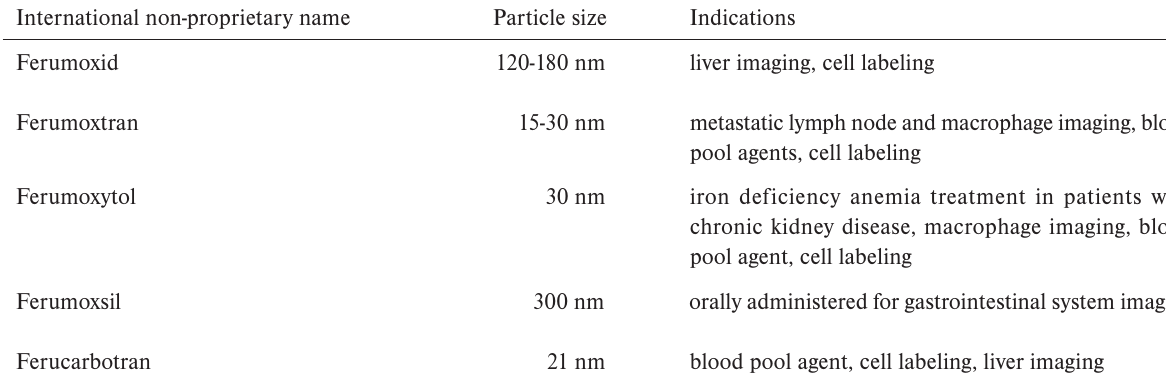
Table 1. Overview of clinically tested types of